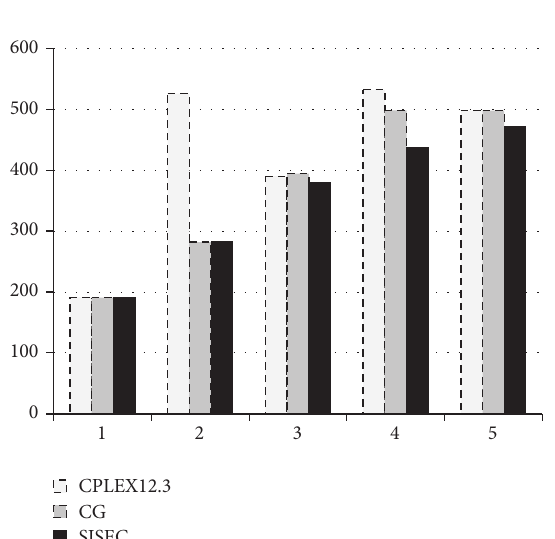
Figure 3: Comparison between exact, CG, and SISEC algorithms for 5